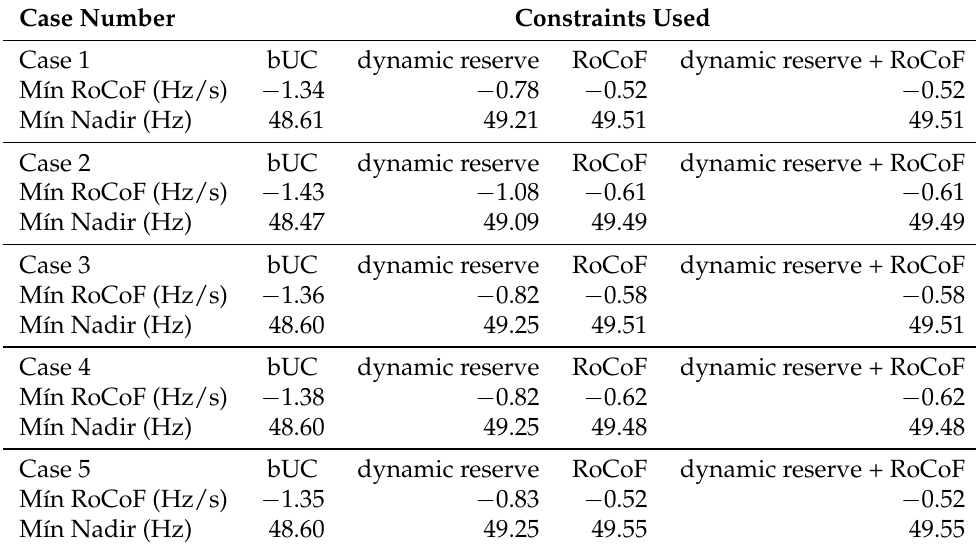
Figure 11. Worst nadir obtained with each constraint in the five cases. Table 4. Minimum RoCoF and Nadir for the five cases and the three ways of constraint